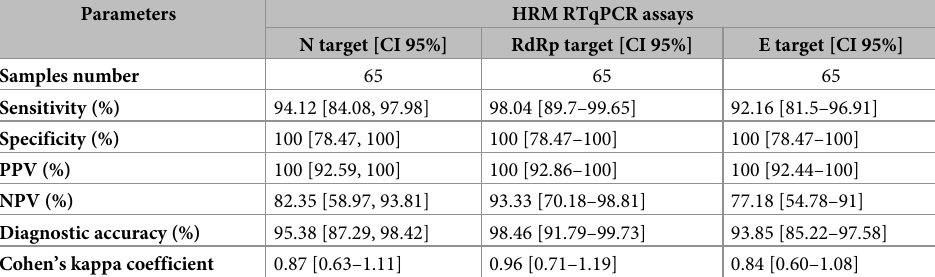
Table 3. Clinical validation of RT-qPCR assays targeting SARS-CoV-2 E, N and RdRp. The parameters of clinical validation were calculated considering RT-qPCR with TaqMan assays as gold standard, using the OpenEpi (v. 3)